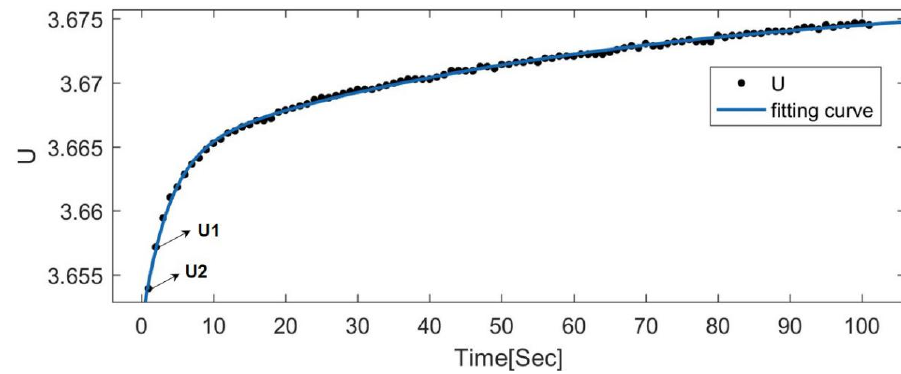
Figure 6. Terminal voltage response curve when the current suddenly reaches 0.